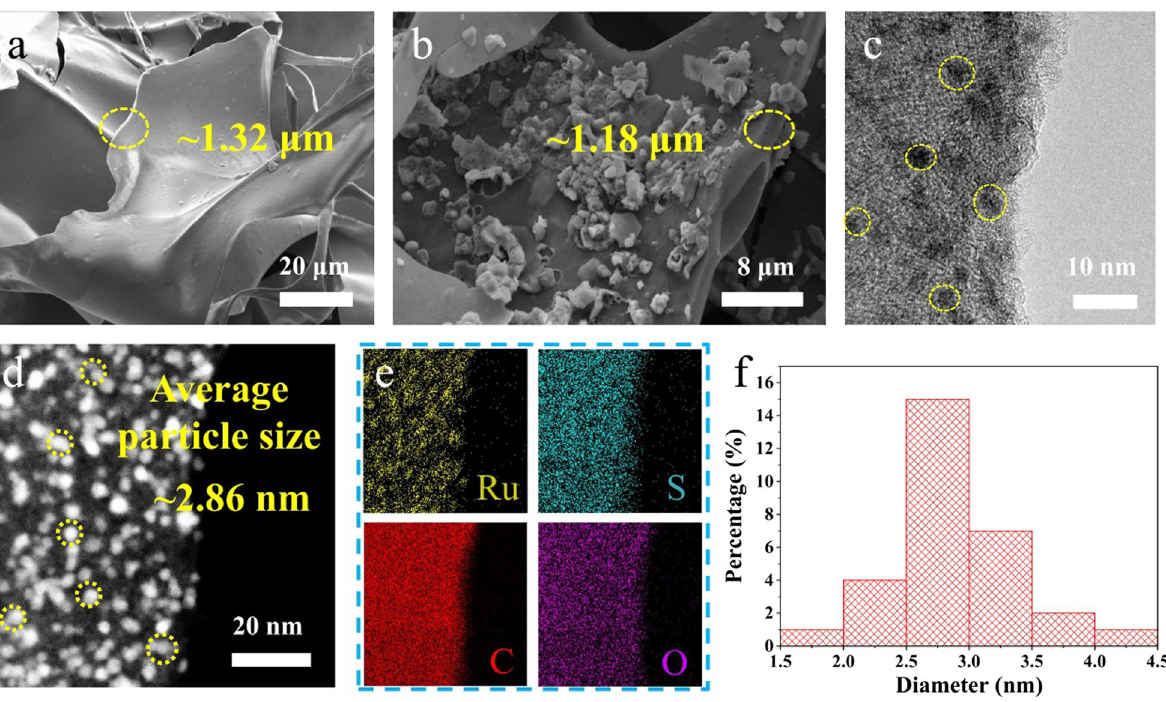
Fig. 2 a SEM image of the composite polymer aerogel. b SEM, c HRTEM, and d HAADF-STEM images of Ru/RuS images of Ru, S, C, and O elements on Ru/RuS 2 -BA. f Particle size distribution of Ru/RuS